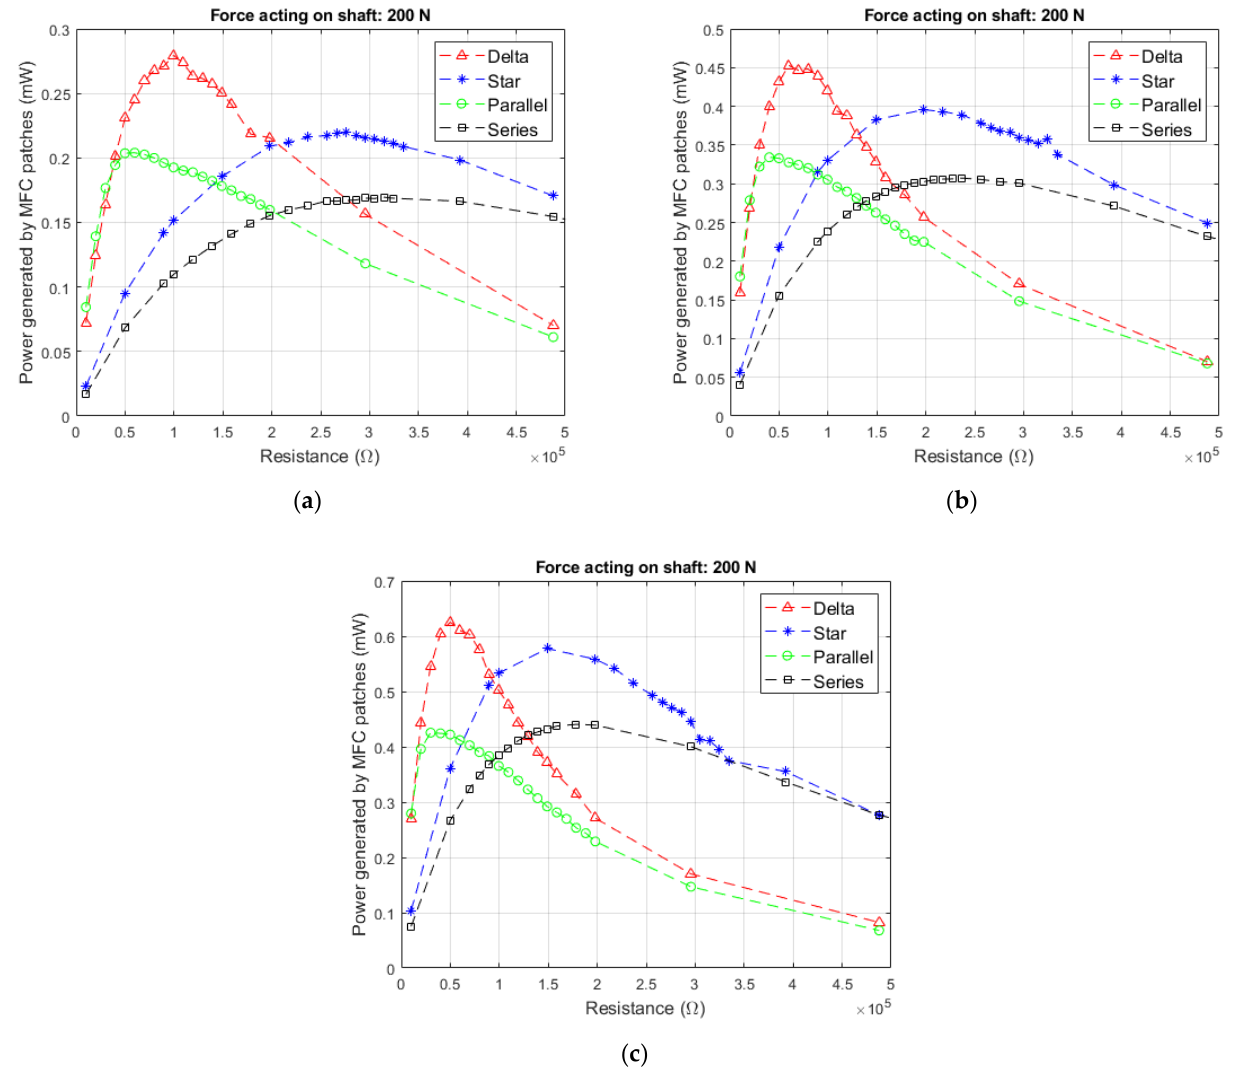
Figure 8. Electrical power generated for a force equal to 200 N: ( a ) rotational speed equal to 10 rps; ( b ) rotational speed equal to 15 rps; and ( c ) rotational speed equal to 20 rps.